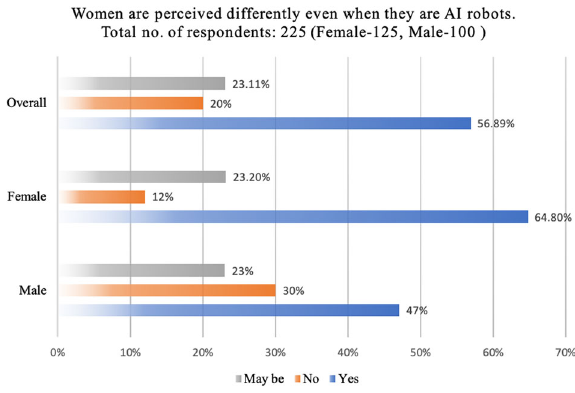
Fig. 13 Women are perceived differently even when they are AI robots. Total no. of respondents: 225 (Female: 125, Male: 100).